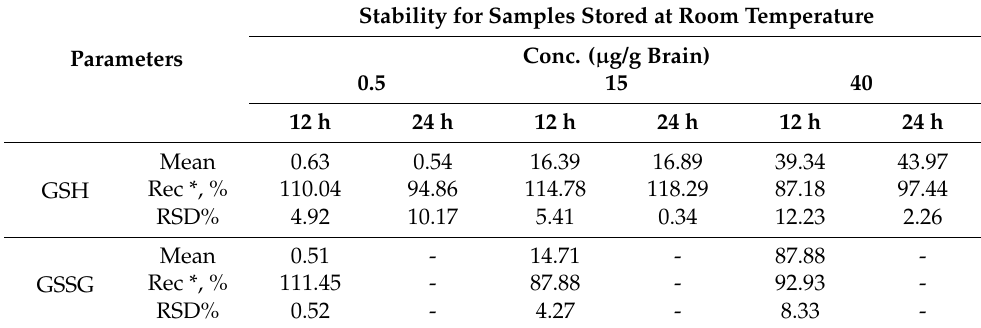
Table 4. Stability assessment for samples stored at room temperature for 12 and 24 h, respectively.